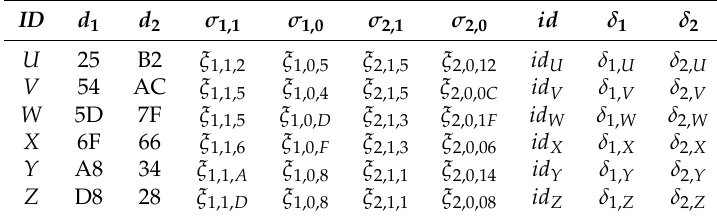
Table 9. Encrypted disguised object order generation by DataNode 2